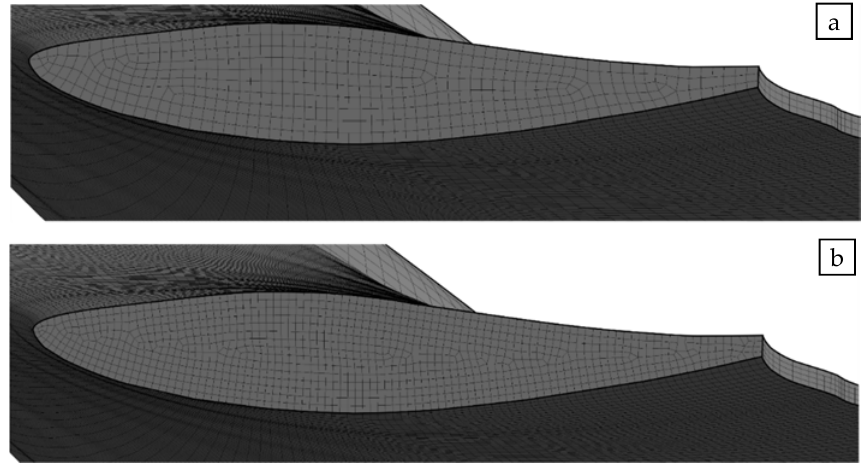
Figure 10. Comparison of blade grids in cross ‐ sections in meshes ( a ) II, III, IV, and ( b ) I.